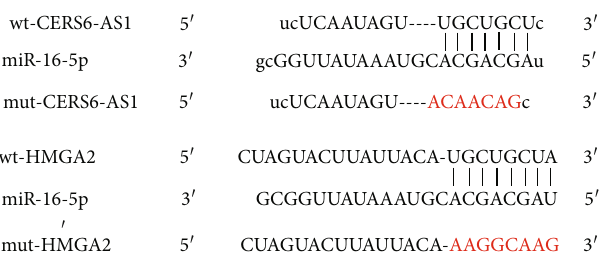
Figure 5: Complementary sequences of CERS6-AS1 and miR-16- 5p and miR-16-5p and HMGA2.